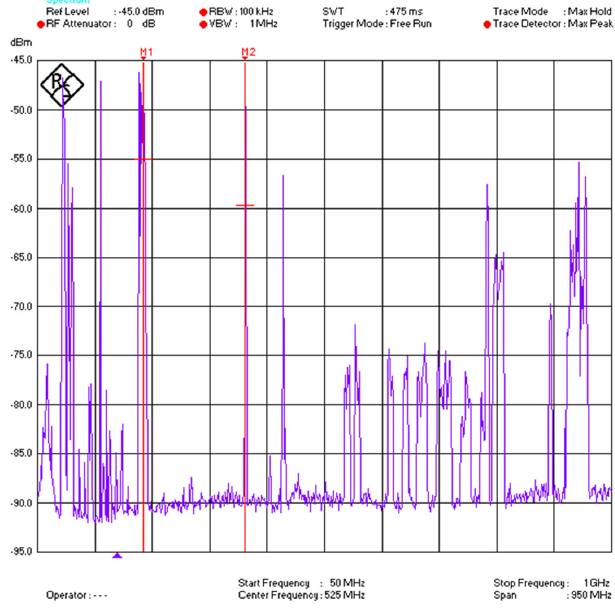
Figure 6. Spectral analysis inside the sports hall.